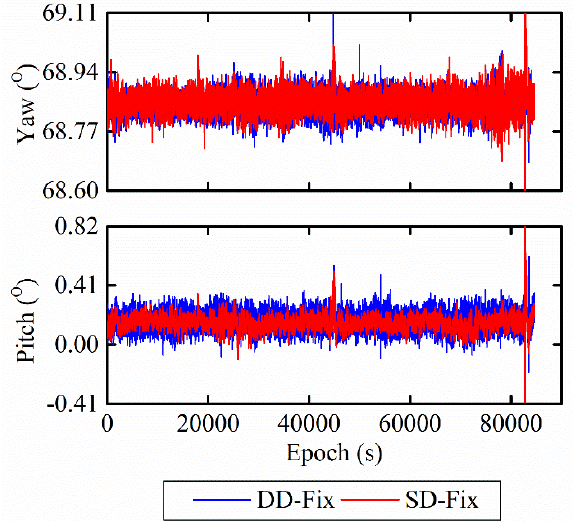
Figure 6. Waveform showing single-frequency and single-epoch kinematic attitude solutions be- tween DD-Fix and SD-Fix before multipath mitigation. Table 3. STDs of yaw and pitch angles between DD-Fix and SD-Fix before multipath mitigation /° . Solution Yaw